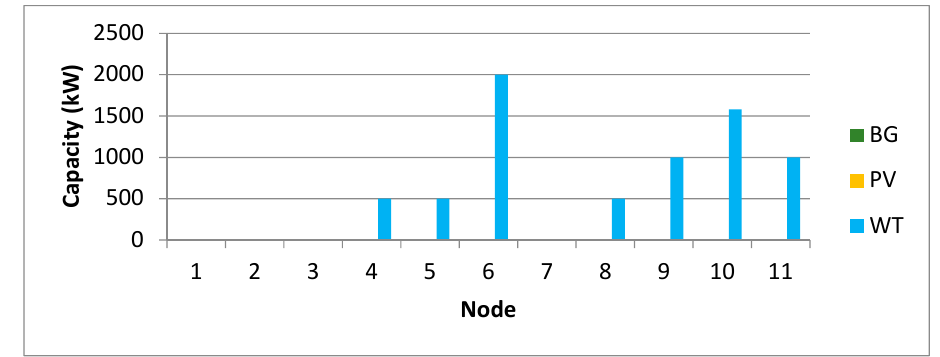
Figure A8. Capacity structure for 40% share of energy from RES in total demand with sizing and allocation of RES and EC.